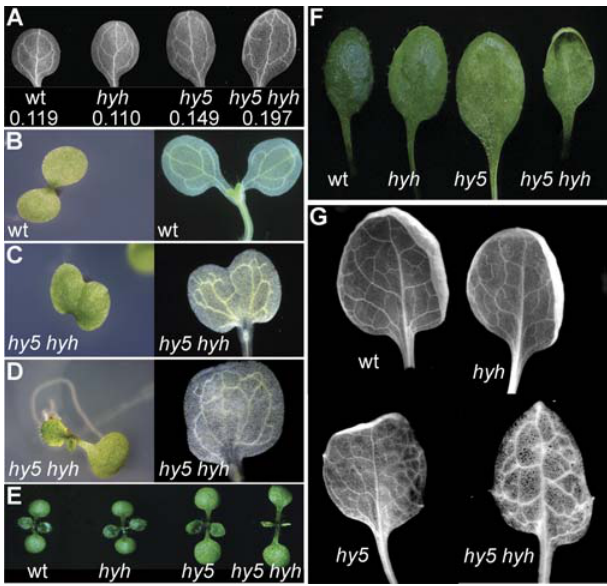
Figure 4. Novel Shoot Phenotypes in hy5 hyh Double Mutants Phenotypic analyses of wt, hy5 , hyh, and hy5 hyh seedlings. (A) Darkfield microscopy images of cotyledons cleared for visualization of the vasculature. The values for each genotype correspond to the average expanded cotyledon size 7 dag in cm 2 . The respective standard errors of the mean are 0.012, 0.011, 0.019, and 0.023 cm 2 . (B) Wild-type cotyledons, before and after clearing. (C and D) As in (B), for representative fused cotyledons of hy5 hyh seedlings. Note the true leaf opposing the fused cotyledon in (D). (E) Representative shoots of 12-d-old light-grown seedlings. (F) Representative first leaves. (G) Darkfield microscopy images of first leaves, cleared for visualization of the